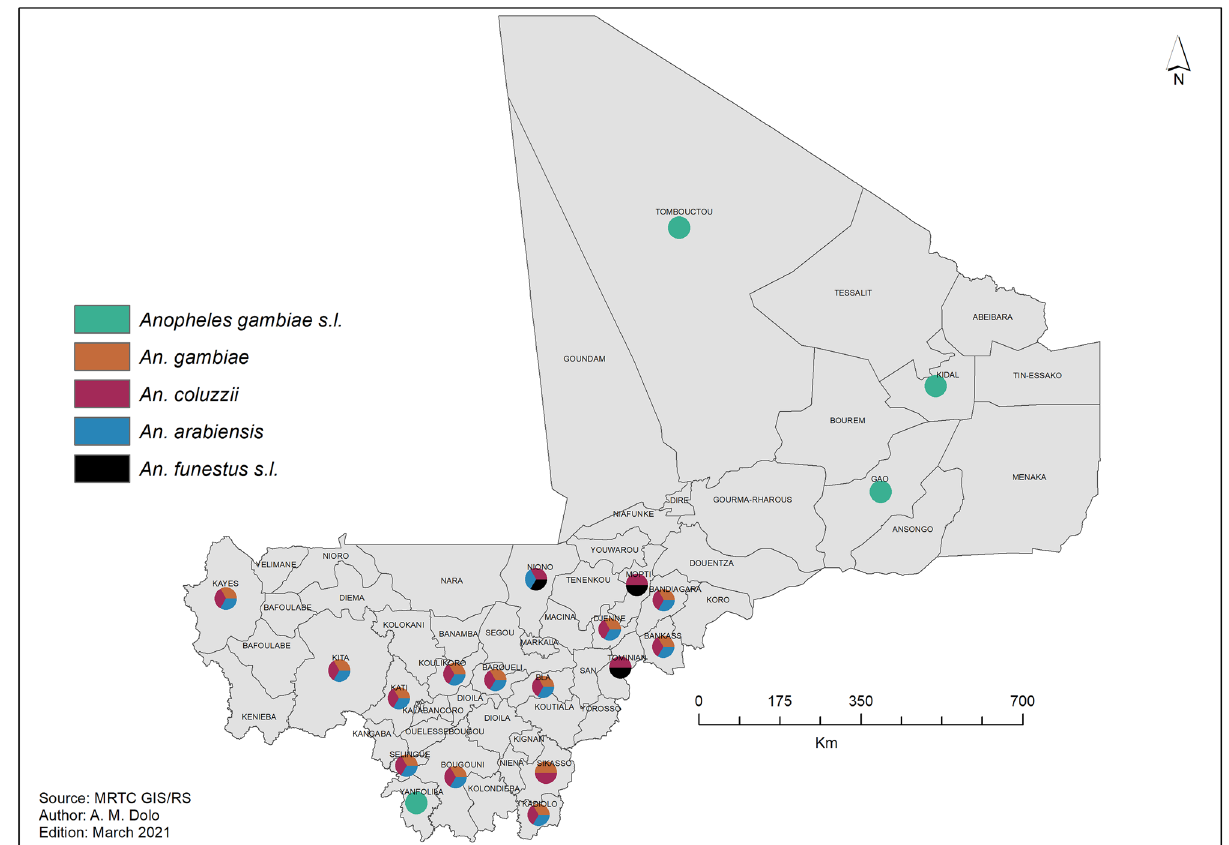
Figure 10. Map of malaria vector distribution, Mali, 2010–2019. The sector diagrams show the presence of different vector species. ArcGIS Desktop version 10.8 software (Environmental Systems Research Institute